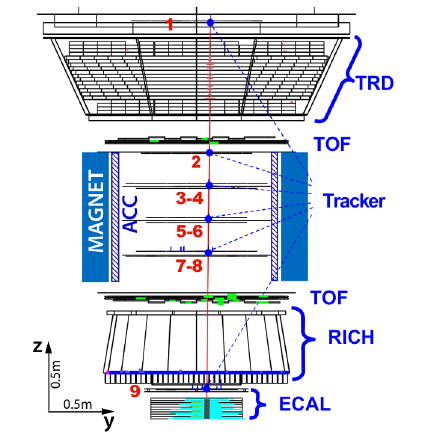
Figure 1. A 868 GeV positron event as measured by the AMS detectorontheISSinthe(y-z)plane. Trackerplanes1-9measure the particle charge, sign and momentum. The TRD identi fi es the particle as an electron / positron. The TOF measures the charge and ensures that the particle is downward-going. The RICH mea- sures the charge and velocity. The ECAL independently identi- fi es the particle as an electron / positron and measures its